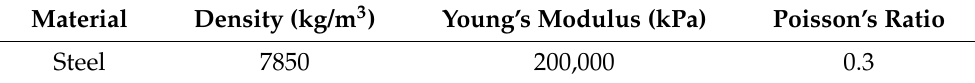
Table 2. Pile material